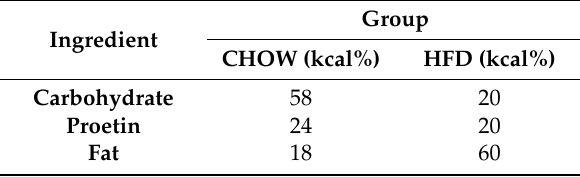
Table 2. Composition of CHOW diet and